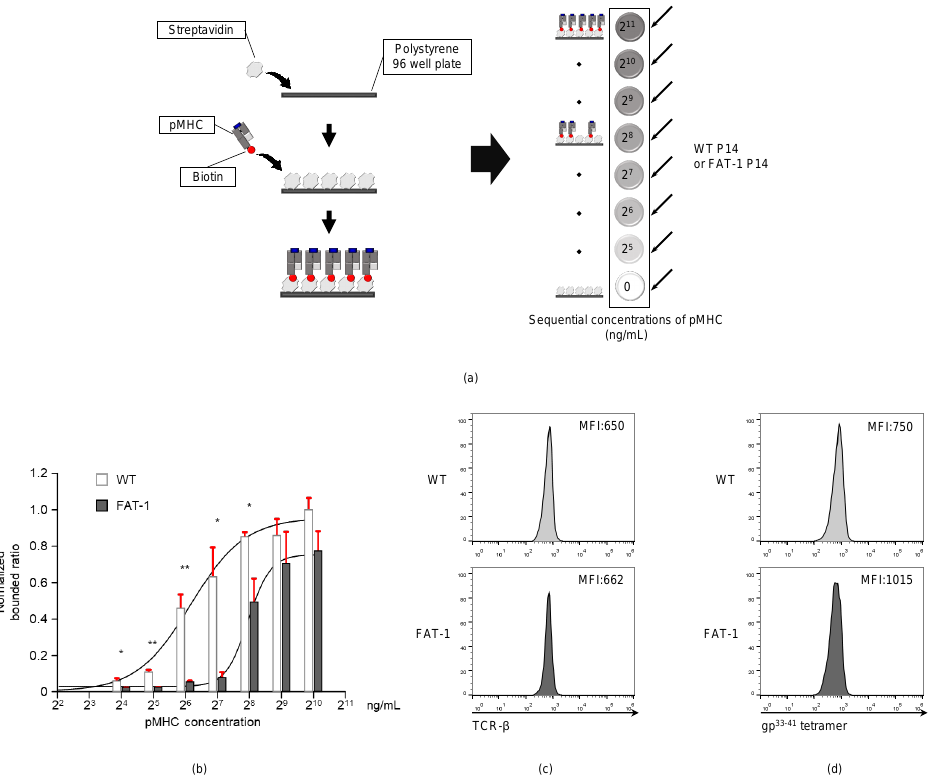
Figure 4. Endogenous n -3 PUFAs decrease the TCR-peptide-major histocompatibility complex (pMHC) interaction of anti-viral CD8 + T cells. ( a ) An experimental scheme is shown. A 96-well polystyrene plate was coated with 100 µ L of streptavidin (10 µ g / mL) and 100 µ L of pMHC (1000 ng / mL to 16 ng / mL concentration range), sequentially. The WT P14 or FAT-1 P14 CD8 + T cells (1.0 × 10 5 cells) were loaded onto the coated wells and incubated at 37 ◦ C for one hour. After incubation, each well was washed with a pre-warmed RPMI medium and the attached cells were counted. ( b ) The attached WT P14 or FAT-1 P14 cells were counted and normalized against the WT P14 cells (pMHC 1000 ng / mL condition). ( c , d ) The mean fluorescence intensities (MFIs) for TCR expression ( c ) and gp 33-41 tetramer staining ( d ) on WT P14 or FAT-1 P14 cells are shown. *, p < 0.05; **, p <